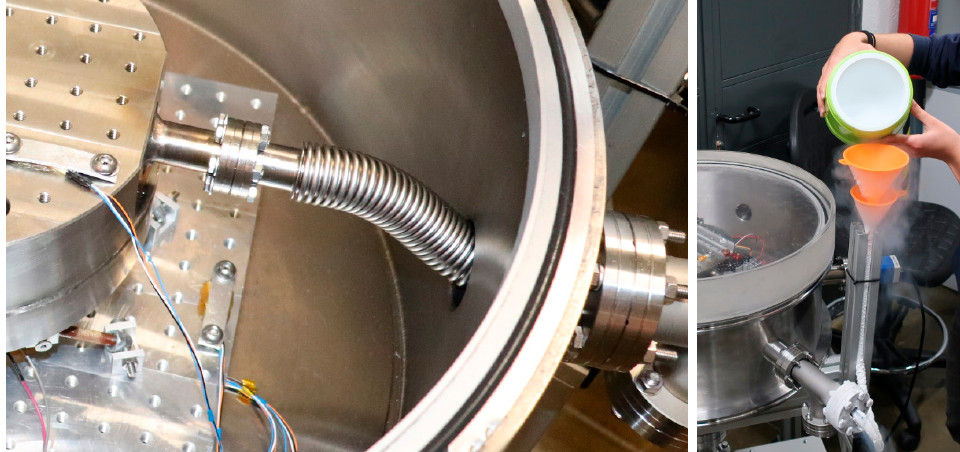
Figure 17. Connection to the internal LN 2 supply through a flexible bellow ( left ). Connection to the external LN 2 supply by direct pouring ( right